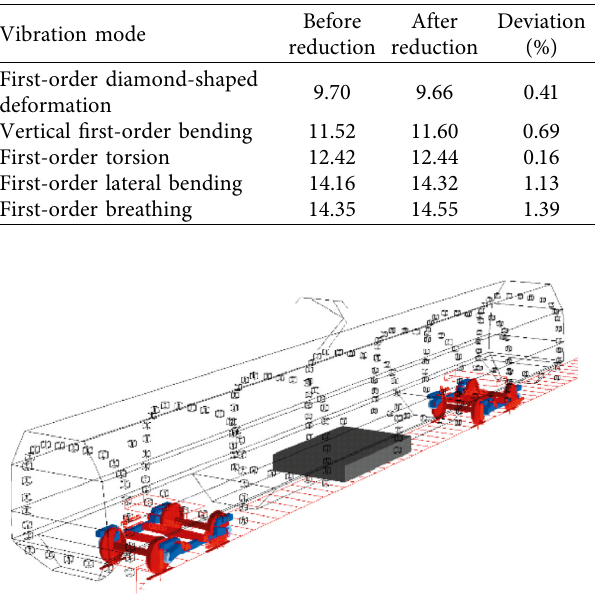
Figure 2: Vehicle rigid-flexible coupling dynamics model.